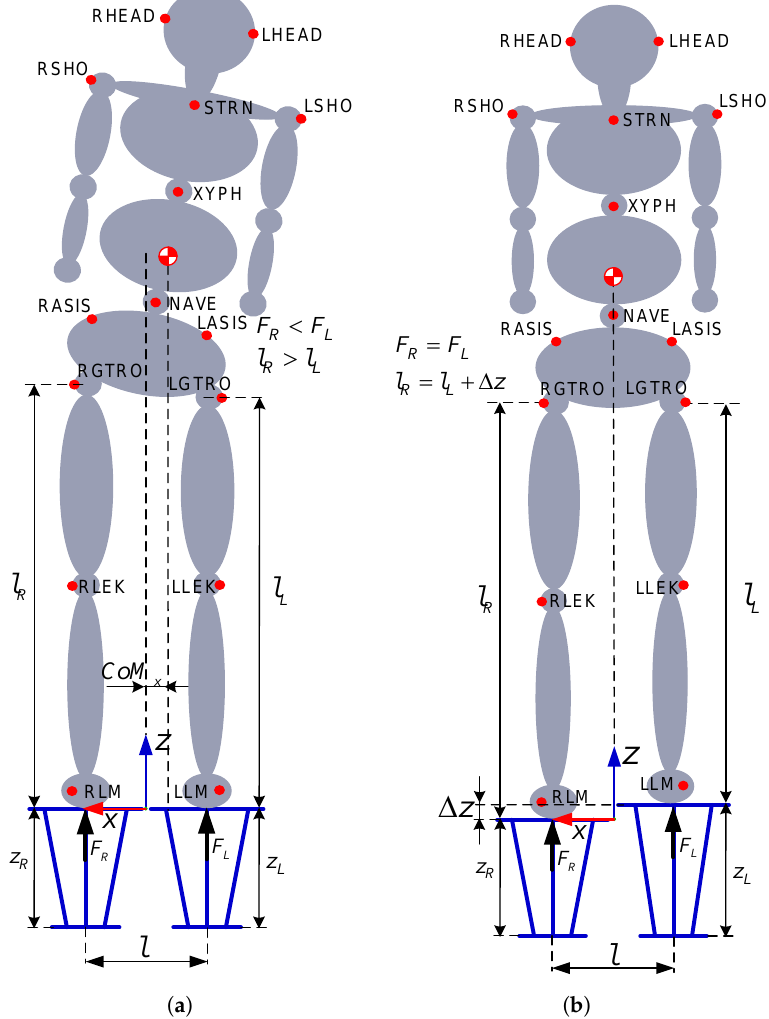
Figure 3. Human Body Balancing: ( a ) human body with LLD ( CoM x < 0); and ( b ) balanced human body ( CoM x =